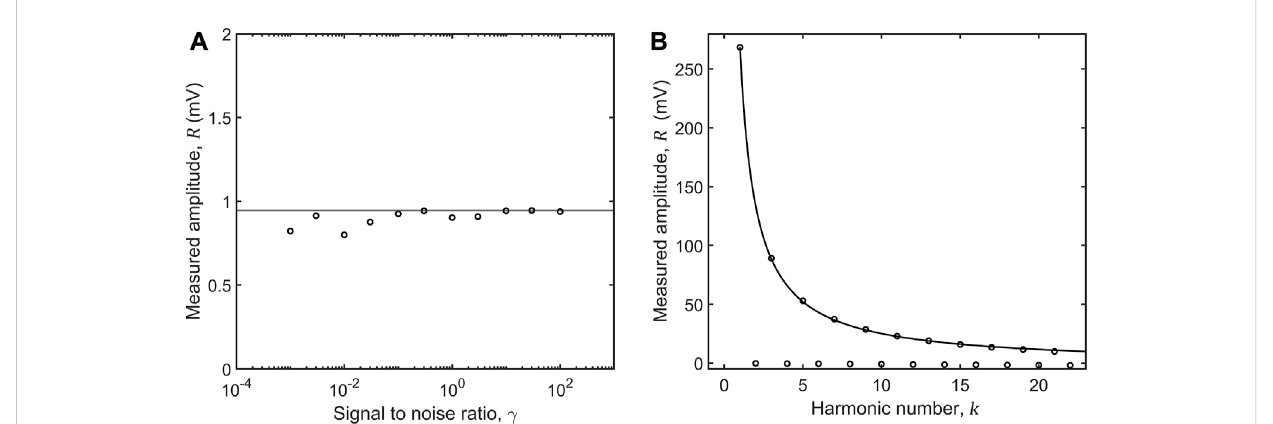
FIGURE 7 (A) Measured amplitude R vs. signal to noise ratio γ for ~1 mV sinusoidal input signals of frequency 1 kHz with varying (white) noise-levels; data were obtained using a 1 kHz reference frequency, a time constant of 6 s, and an input gain of 1. The “ correct ” (noise-free) value of the signal amplitude is represented by the horizontal line. (B) Measured amplitude R vs. harmonic number k for the fi rst 22 harmonics of a ~250 mV square-wave of frequency 1000 Hz; data were obtained using reference frequencies matched to the frequency of the corresponding harmonic, a fi xed time constant of 0.6 s, and an input gain of 1. The curve indicates a least-squares fi t of the odd harmonics k (cid:1) 1 , 3 , ... 21 to an equation of the form R ( k ) (cid:1) R ( 1 ) / k .